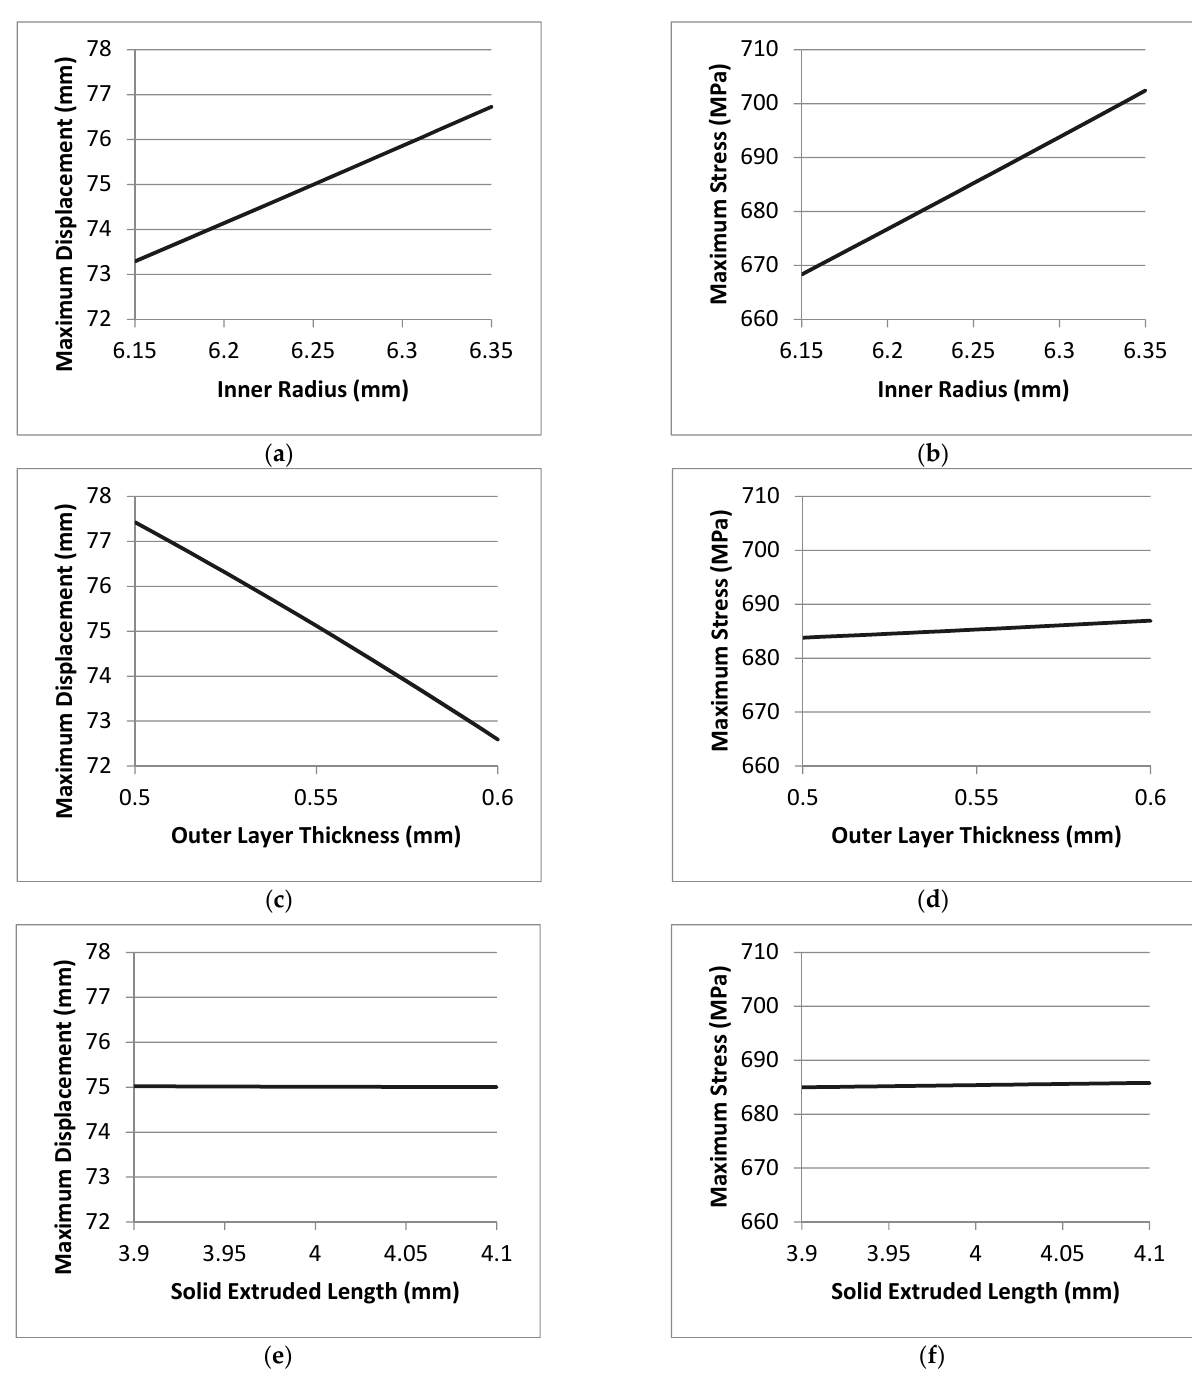
Figure 22. Design of experiment results and the changes in the output with respect to the input: ( a ) Maximum displacement vs. inner radius. ( b ) Maximum stress vs. inner radius. ( c ) Maximum displacement vs. outer layer thickness. ( d ) Maximum stress vs. outer layer thickness. ( e ) Maximum displacement vs. solid extruded length. ( f ) Maximum stress vs. solid extruded length.